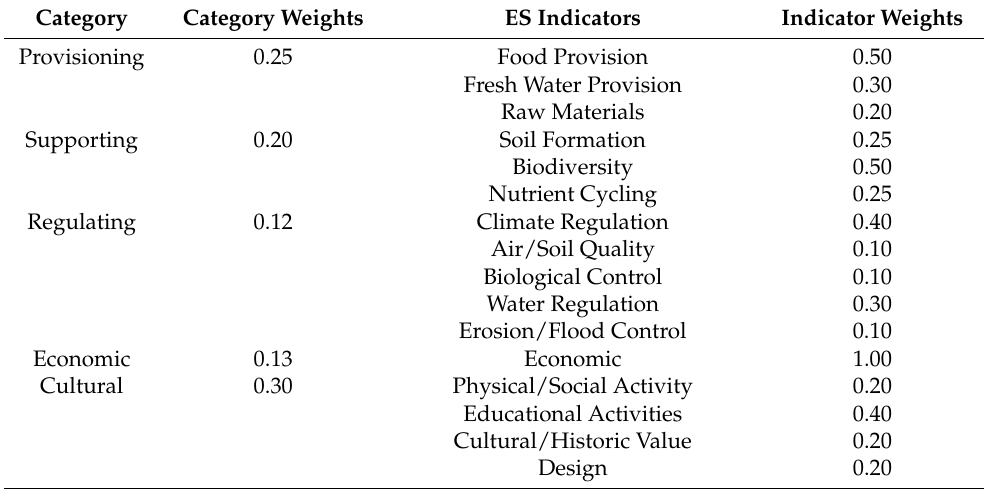
Table 3. Indicator